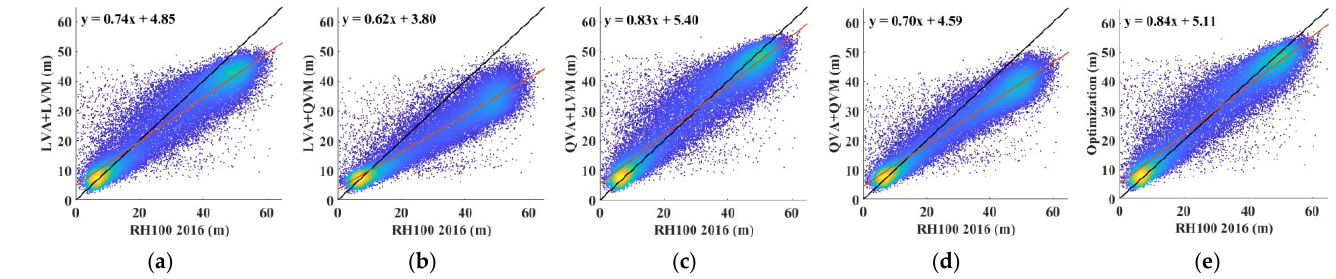
Figure 12. Density plots of forest height inversion results versus the LVIS RH100 metric over the PNP site. Black lines are y = x and red lines are the linear fits. ( a ) LVA + LVM; ( b ) LVA + QVM; ( c ) Table 4. Accuracy metrics of forest height inversion results over PNP.